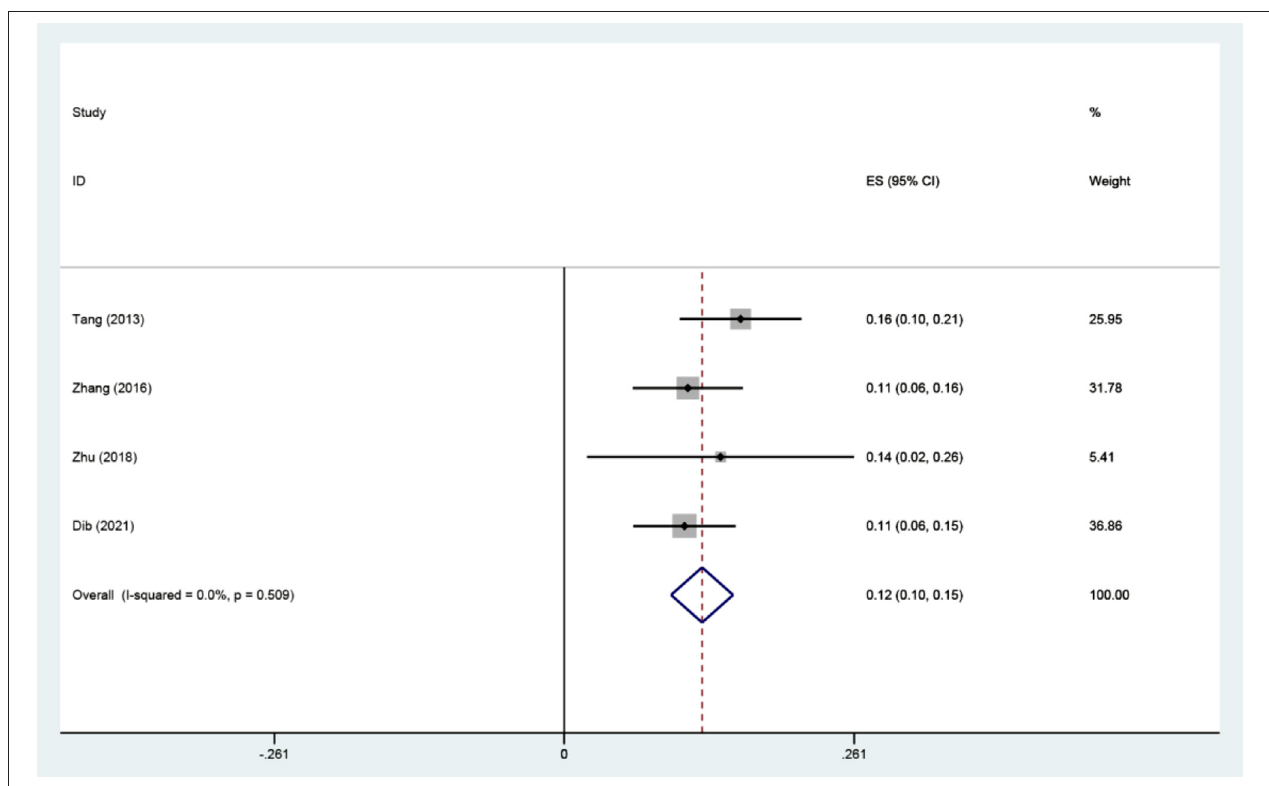
FIGURE 2 | The association between IAD and drinking